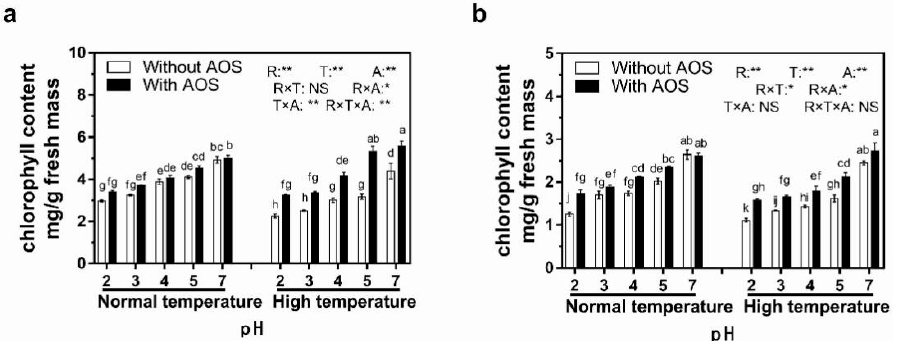
Figure 7. Effect of alginate oligosaccharides (AOS) in chlorophyll a and b contents of leaves subjected to low pH stress at different temperatures for 7 days. ( a ) Chlorophyll a. ( b ). Chlorophyll b. The same letter followed by the data in the same parameter indicates an insignificant difference among different treatments ( p < 0.05). The p values of three-way ANOVA for rain pH (R), temperature (T), AOS (A) and their interaction (R × T, R × A, T × A,R × T × A) are shown: **, p ≤ 0.01; *, p ≤ 0.05; NS, p > 0.05.